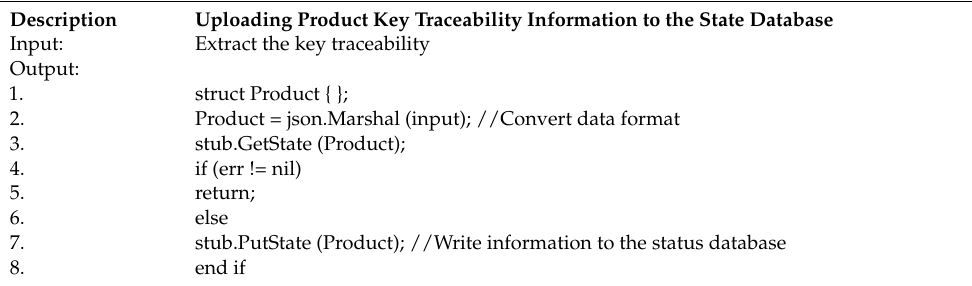
Algorithm 1. Process of uploading the key traceability information to the state database.